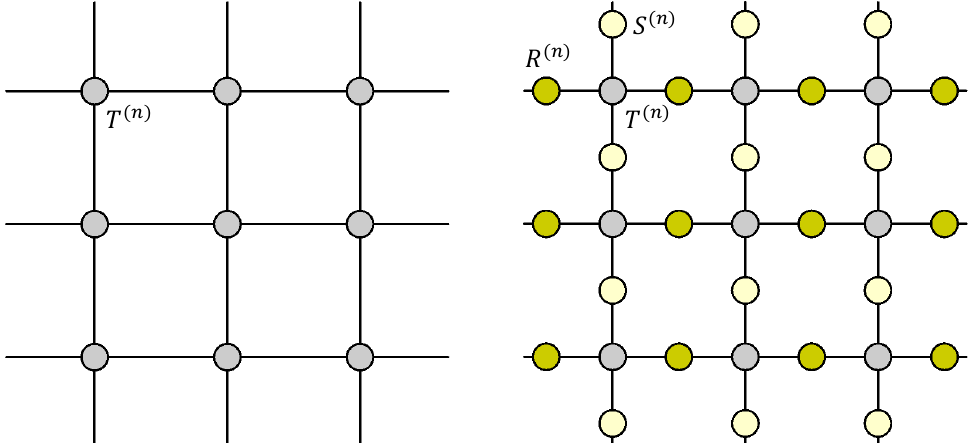
Figure 1 . (Left) Tensor network representation considered in the usual TRG algorithms. A local tensor T ( n ) lives on each lattice site. n denotes the renormalization step. (Right) Tensor network representation considered in the BTRG. Dark and light yellow symbols are the bond weights denoted by R ( n ) and S ( n ) , respectively, which are associated with the edges of the tensor network. These bond weights are initialized by the identity matrices and updated by the renormalization step of the